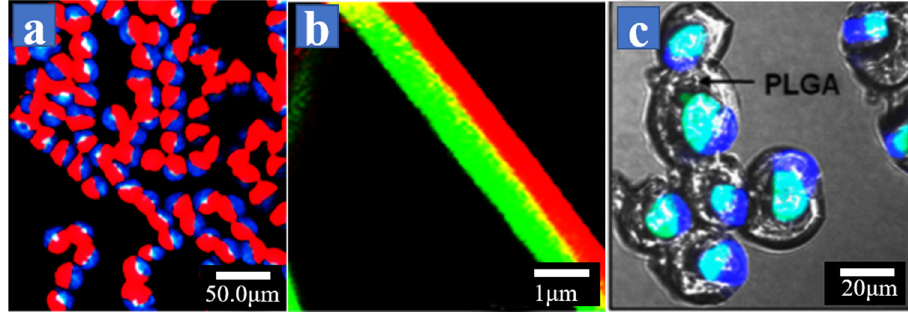
Figure 9: CLSM images of ( a ) PLGA - PLGA/PVCi side - by - side bi - component fi ber, ( b ) PVP/PCL side - by - side fi ber, and ( c ) PVCi/ER core/PLGA shell micro fi bers. ( a ) Adapted with permission ( 126 ) Copyright 2010, Wiley - VCH GmbH & Co. KGaA; ( b ) adapted with permission ( 127